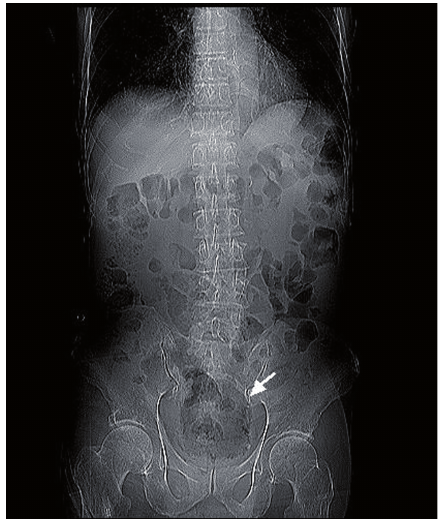
figure 1 - Radiography of the kidneys, ureters, and bladder revealed a low density over the whole bladder area and linear collection of gas along bladder wall